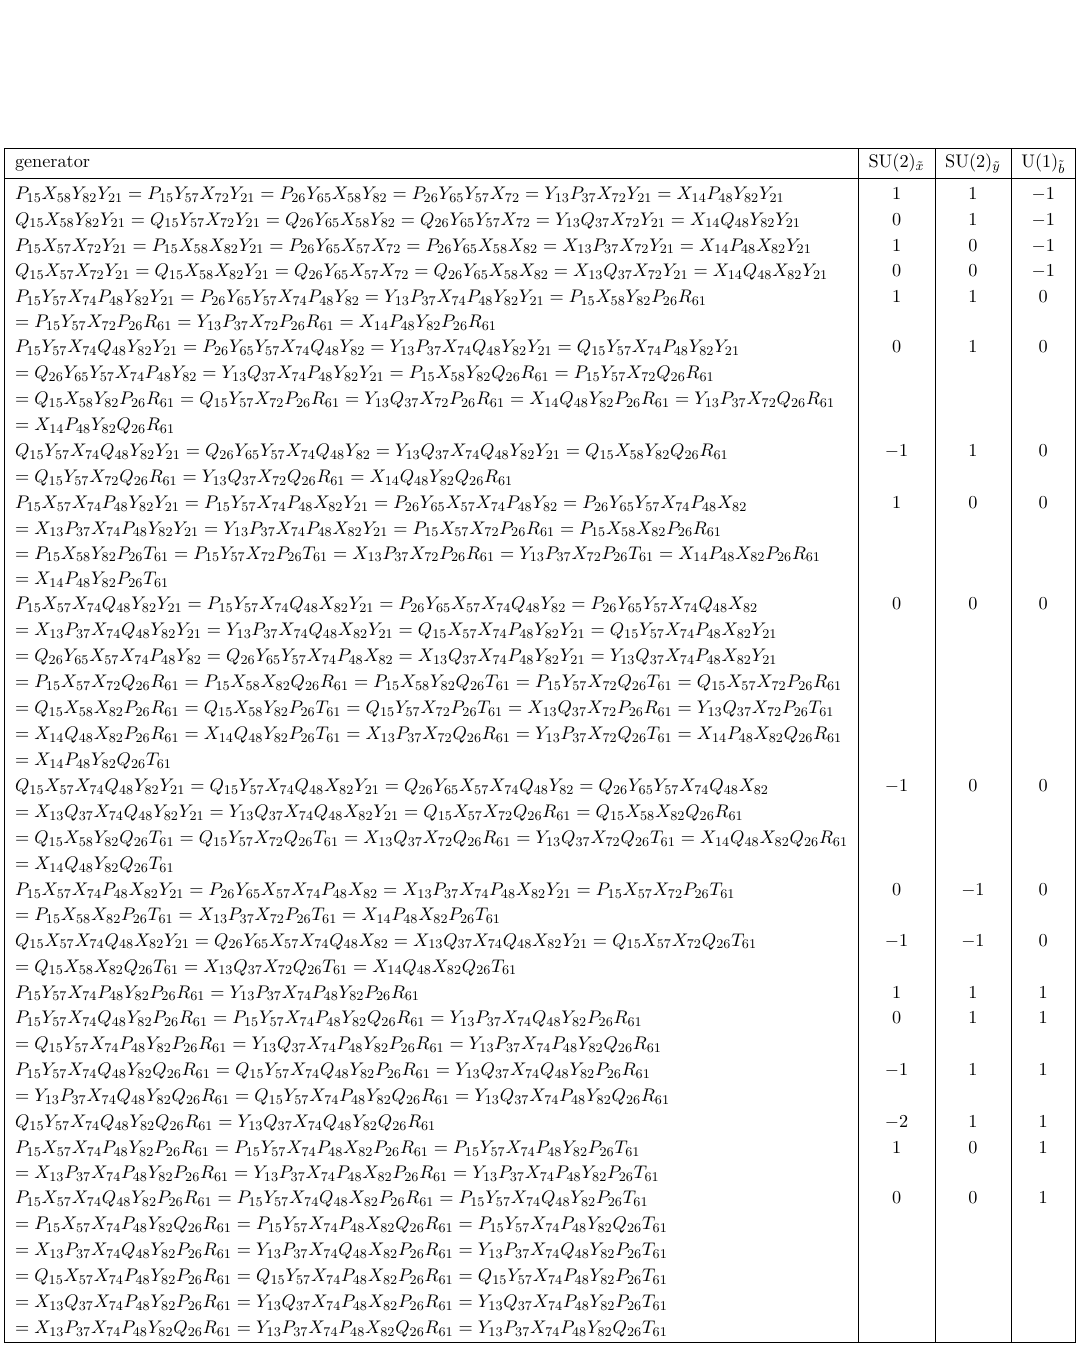
Table 37 . The generators in terms of bifundamental chiral fields for Model 9 (Part 1)